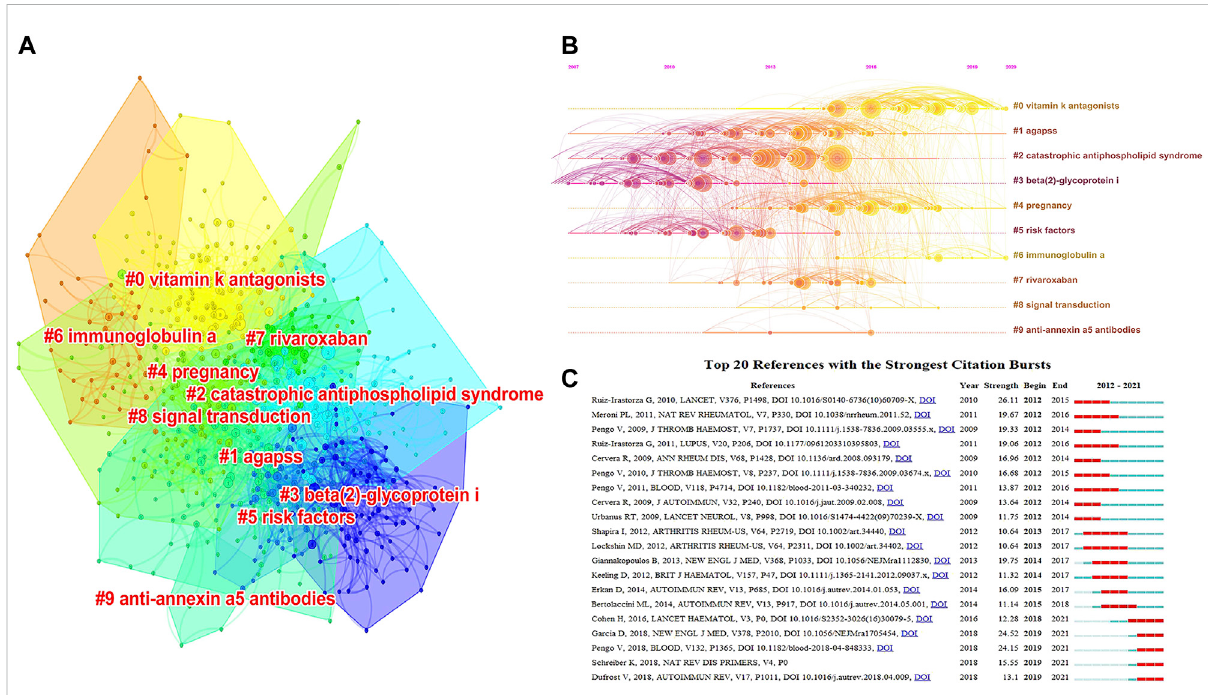
FIGURE 5 (A) Ten clustering maps of reference co-citation analysis based on CiteSpace. Each cluster is represented by a different color, and the smaller the number label, the larger the cluster pro fi le and the more co-cited references (dots) it contains. (B) Timeline view map of reference co-citation analysis generated by CiteSpace. The elements on the horizontal axis represent co-cited references; the position of the element on the horizontal axisdenotesthetimeofthe fi rstoccurrence;andthelineconnectingtheelementsdenotestheco-citedrelationship.Thesizeoftheelementis proportionaltothecitationcountofthereference.Amoreyellowcolorindicatesclosertotheyear2021,andamoreredcolorindicatesclosertothe year2012. (C) Top20referenceswiththestrongestcitationburstsbyCiteSpace.Eachrectanglerepresentsayear.Greenrectanglesindicatethetime interval, and red rectangles indicate the duration of the burst from the beginning to the end.